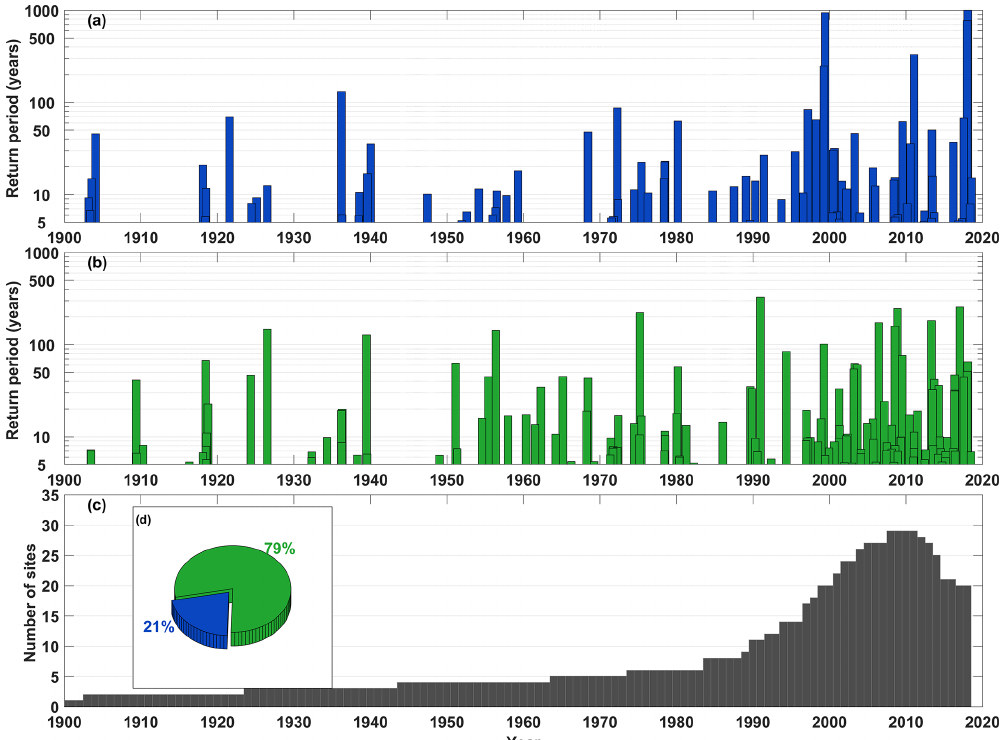
Figure 2. (a) Return period of the highest storm tides in each of the 85 extreme storm-tide events (resulting in 155 extreme storm-tide observations), offset for mean sea level; (b) return period of the highest skew surges in each of the 135 skew-surge events (resulting in 191 extreme skew-surge observations); (c) the number of sites per annum for which sea-level data are available across the 30 sites; and (d) pie chart showing the number of skew-surge events that led to extreme storm-tide events (blue) and the number that did not